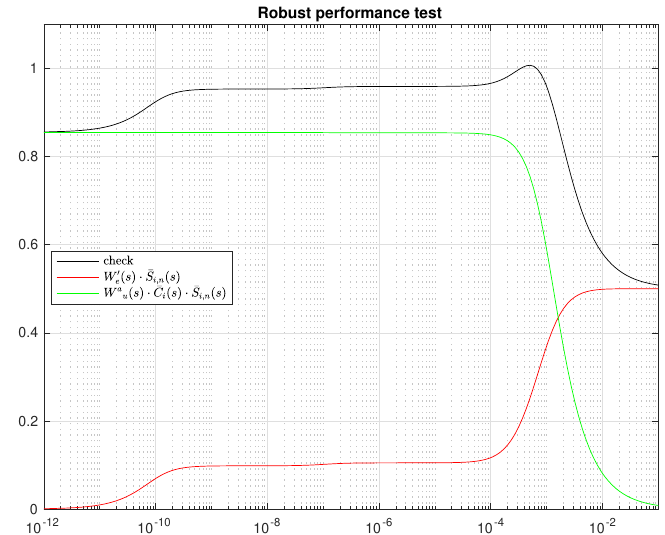
Figure 19. Formal robust performance check for the closed-loop system step response with ¯ C i ( s ) and W (cid:48) e ( s ) .